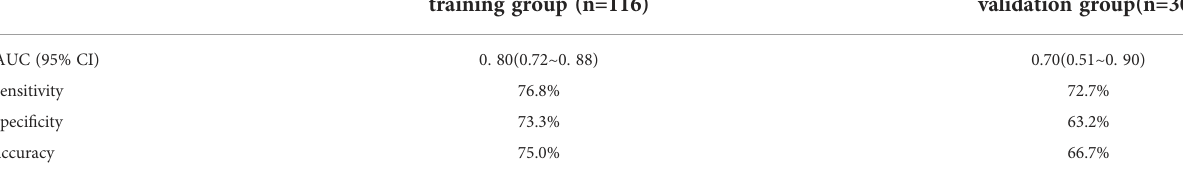
TABLE 2 Predictive effectiveness of radiomics model in the training group and validation